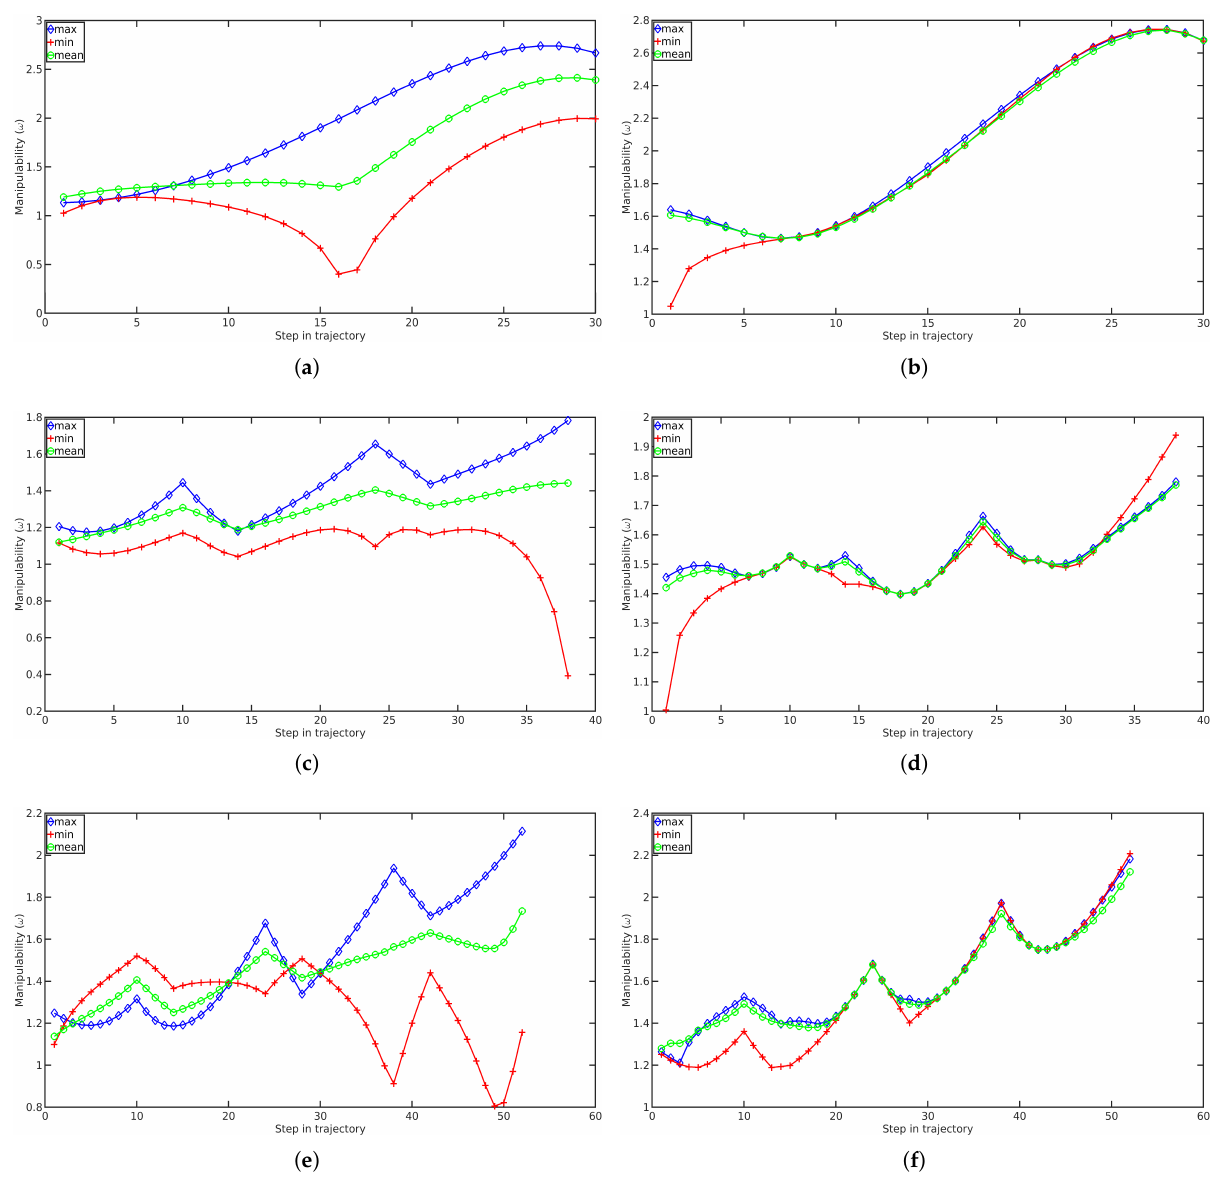
Figure 2. A comparison of the manipulability metric evolution for case studies I, II and III. Cases IA, IIA and IIIA were carried out over a total of N = 2000 sample waypoints along the desired task-space trajectory. The blue line represents the trajectory that presents the maximum value in terms of mean manipulability along the line that the algorithm is able to achieve, red is the minimum and green the mean value across all the runs. The corresponding simulations IB, IIB and IIIB were obtained by using SCO with K=20 samples. ( a ) Case study I A, ( b ) Case study I B, ( c ) Case study II A, ( d ) Case study II B, ( e ) Case study III A, ( f ) Case study III